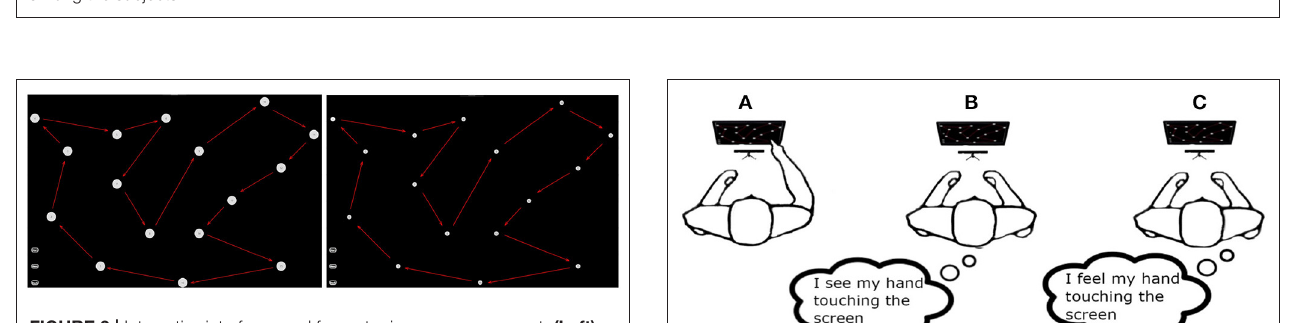
FIGURE 3 | Interactive interface used for motor imagery assessment. (Left) The easy task; (Right) the difficult task.